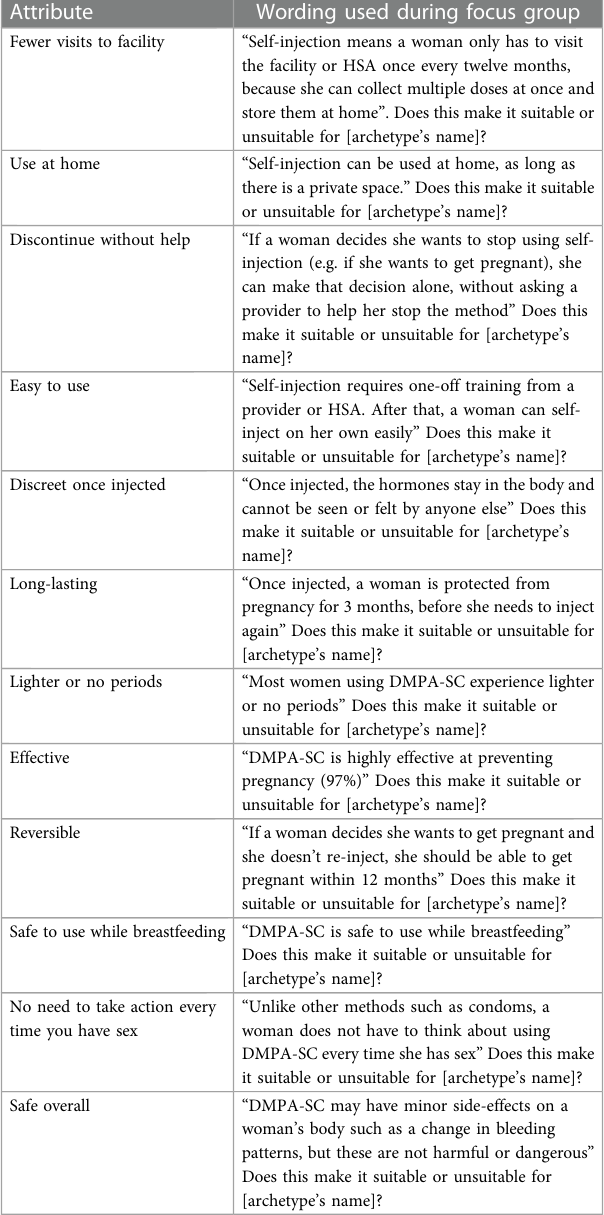
TABLE 1 Attributes of DMPA-SC introduced to adolescents during focus group